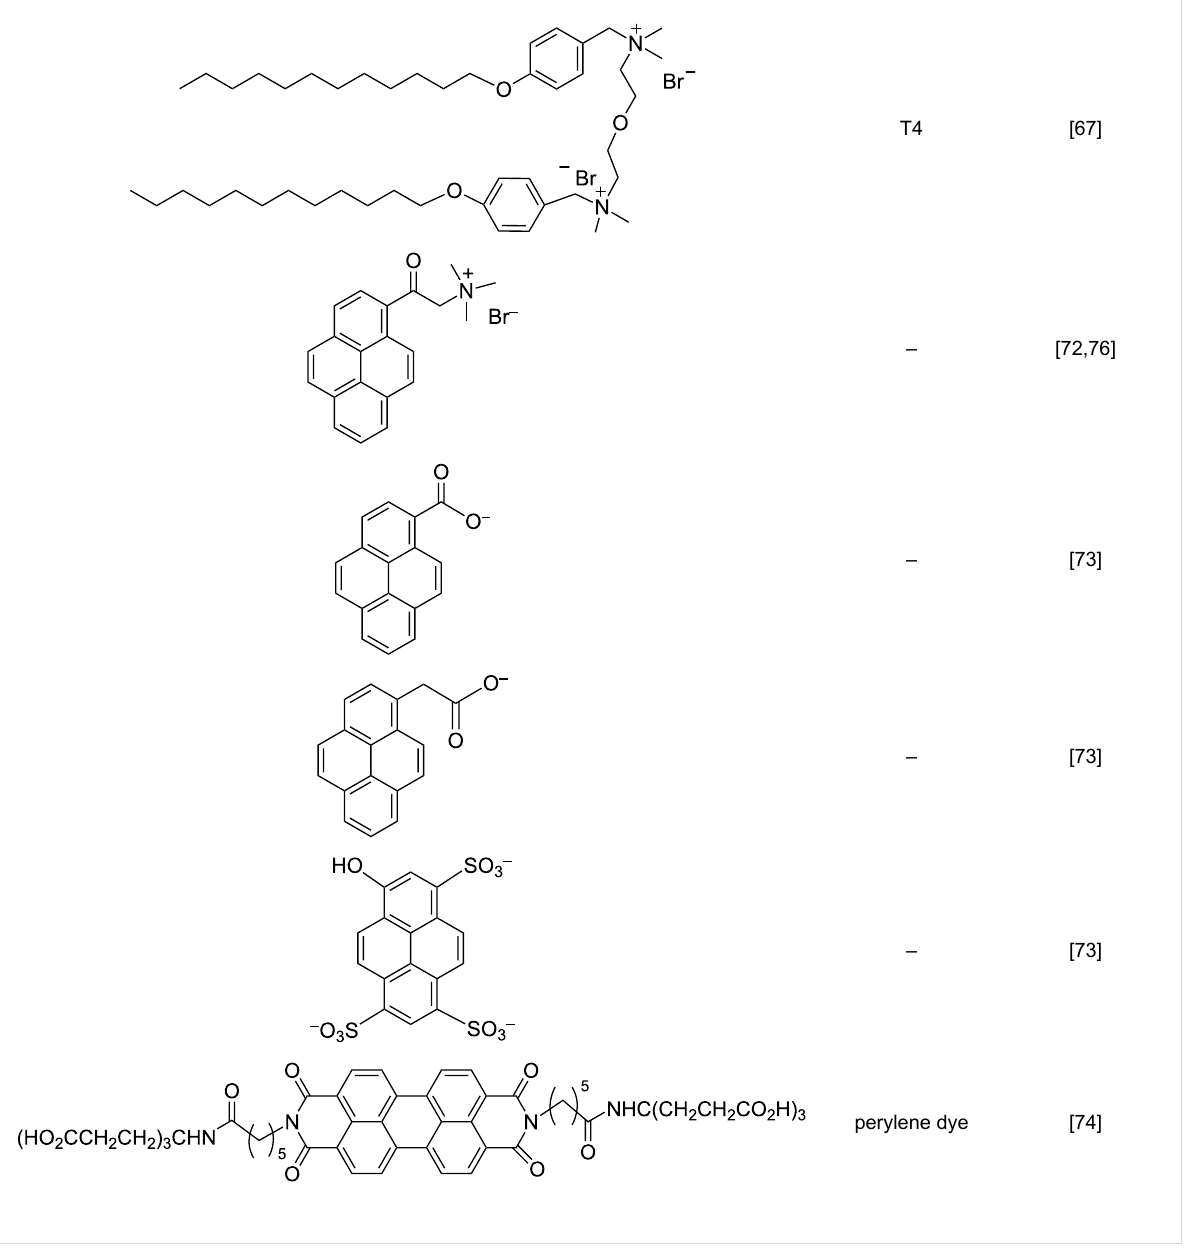
Table 2: Some amphiphilic molecules used for the dispersion of CNTs in water.